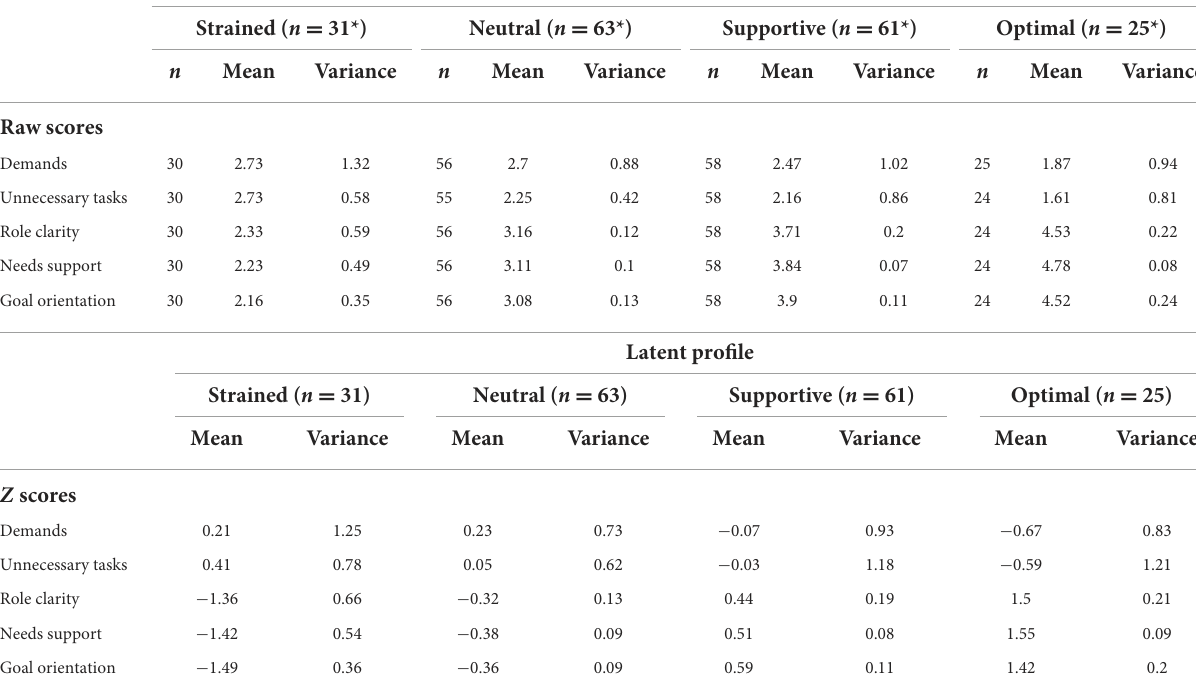
TABLE 3 Means and variances of the raw scores and z scores of the five co-care factors at T1 ( N = 180).